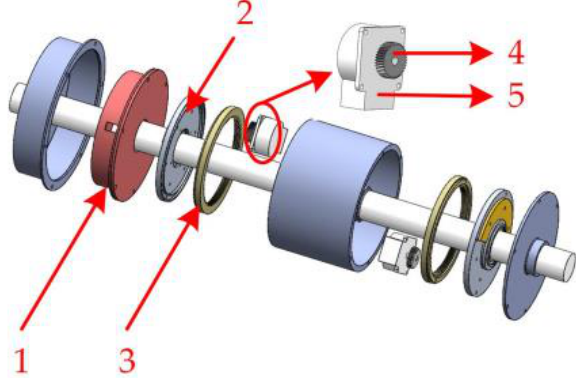
Figure 10. Explosion diagram of automatic balance actuator: 1. control module; 2. counterweight component; 3. ring gear; 4. planetary gear; 5. ultrasonic motor.